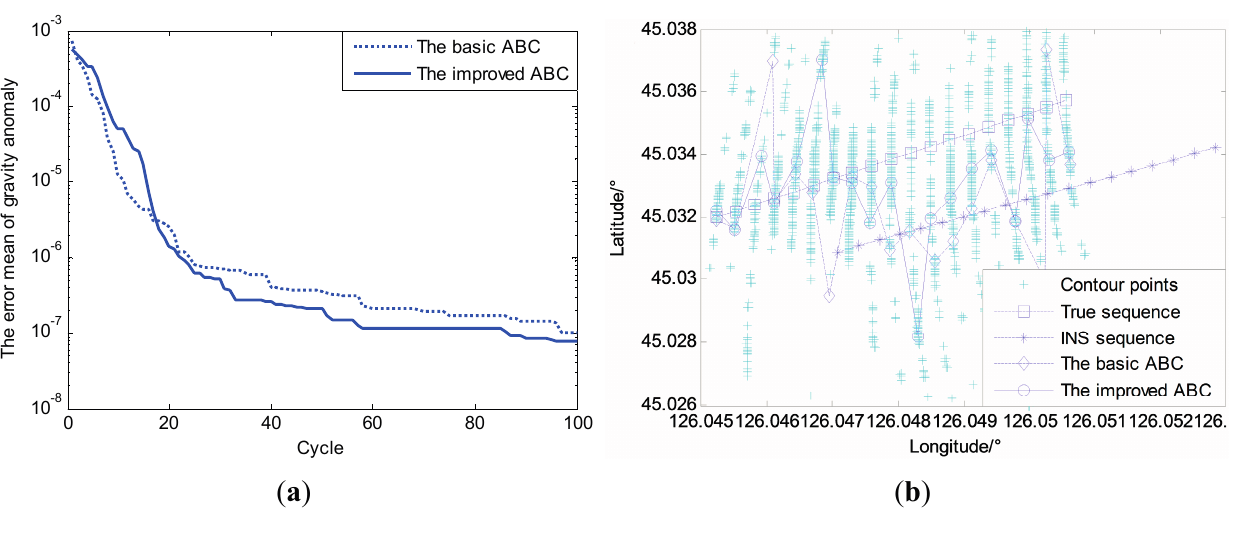
Figure 11. ( a ) Convergence curves for single point search; ( b ) Matching results for single point